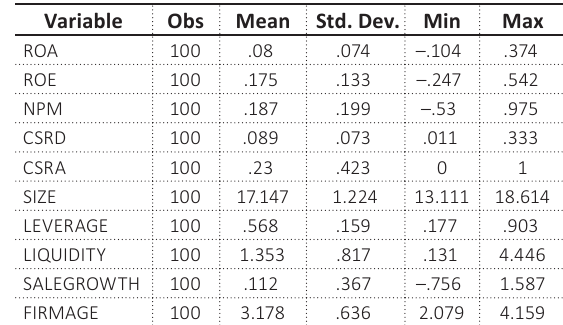
Table 4. Descriptive statistics for large-cap firms